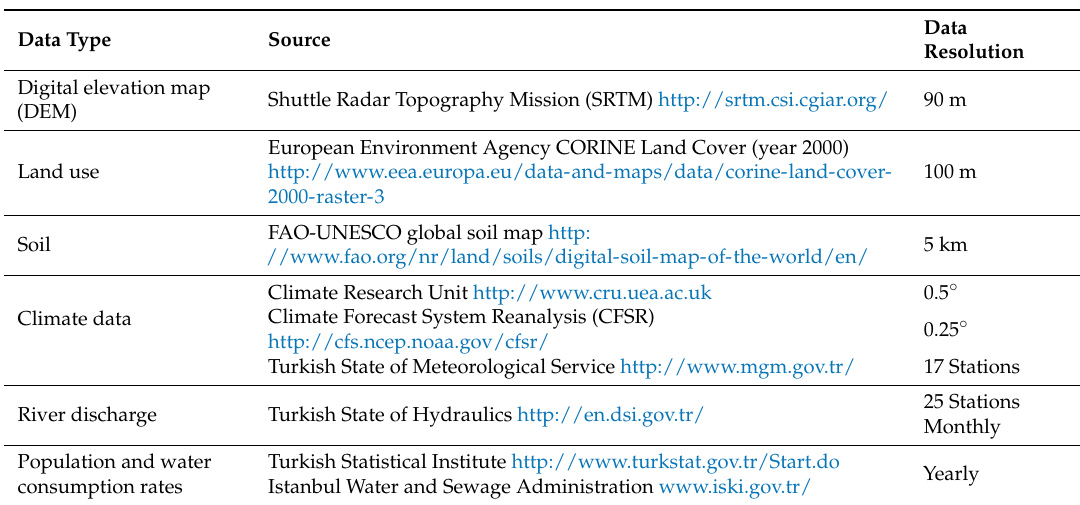
Table 2. Data description, source, and resolution in the current